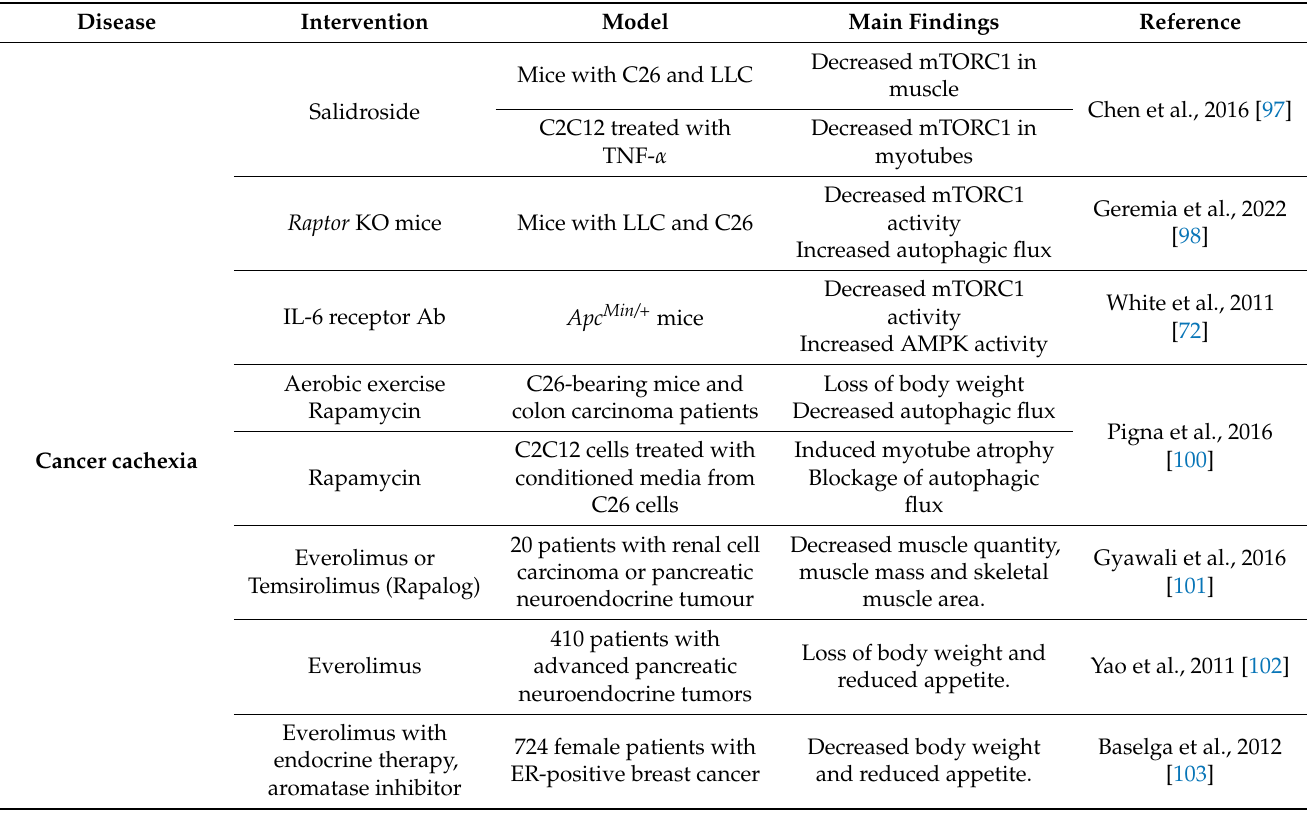
Table 1. Strategies and studies targeting cancer cachexia and sarcopenia.